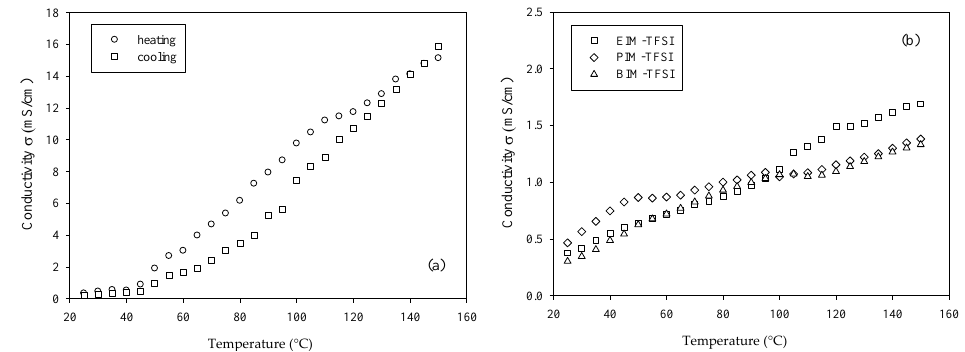
Figure 2. Ionic conductivity of synthesized PILs: ( a ) MIM-TFSI and ( b ) EIM-TFSI, PIM-TFSI, and BIM-TFSI during the heating cycle.